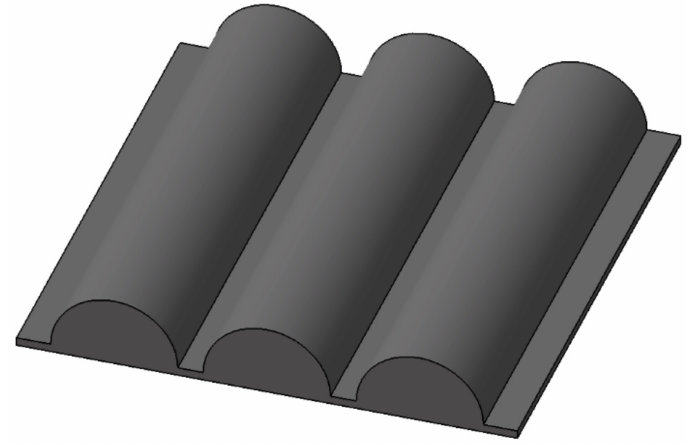
Figure 6. Crush plate for module as per UN/ECE-R100.02:2013 [98], GTR 20:2018 [108], SAE J2464:2009 [89], ISO 12405-3:2014 [84], and FreedomCAR:2006 [92]. For example, UN/ECE-R100.02:2013 [98] and GTR 20:2018 [108] specifies that the